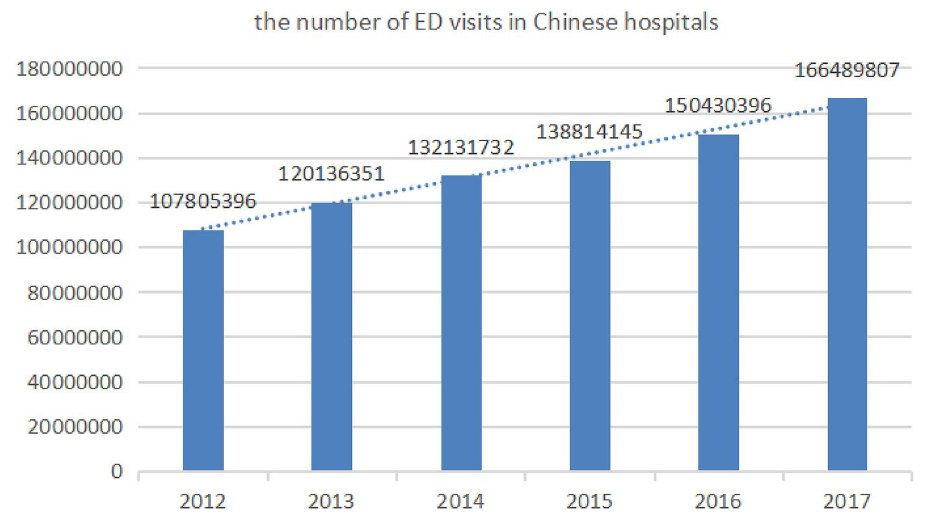
Figure 1. The number of ED visits in Chinese hospitals during the years